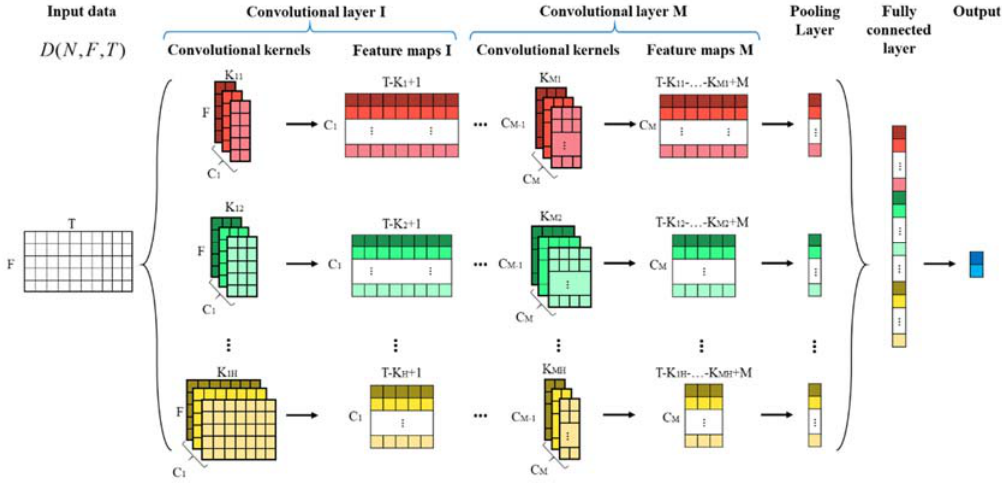
Figure 6. Proposed network structure for electricity theft detection.